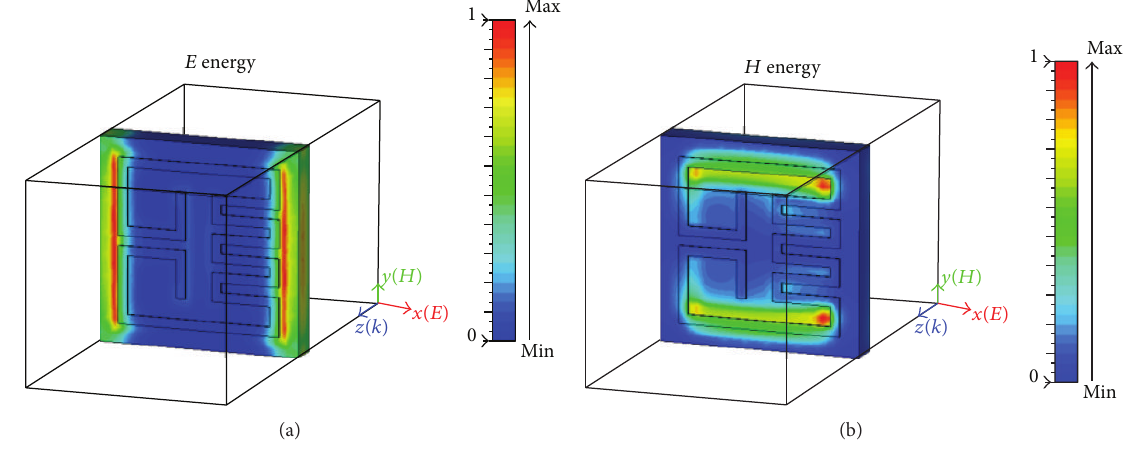
Figure 5: Electric and magnetic field distribution in FL-LHM